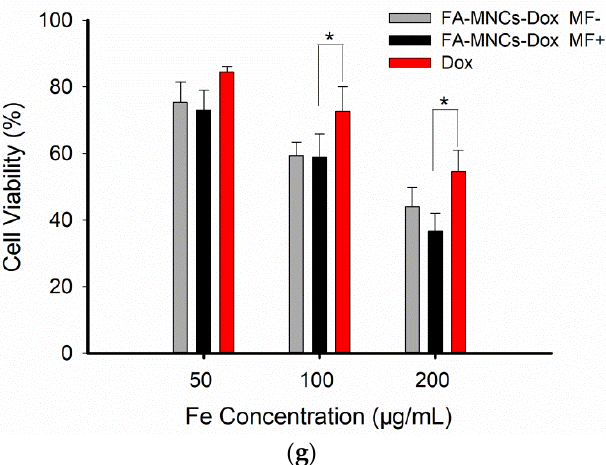
Figure 4. Killing of leukemic cells in vitro by the magnetic nanochains actuated by rotational magnetic field. ( a ) Rotational magnetic field significantly reduced the survival rate of K562 cells. ( b ) Morphological alteration of K562 cells treated by rotational magnetic field. (MF − means there is no magnetic field, while MF+ means there is a magnetic field. Scale bar: 50 µ m). ( c ) TEM image of intracellular distribution of magnetic nanochains. Inset is the local magnification. ( d , e ) TEM images of lysosomes containing magnetic nanochains in the absence (MF − ) and the presence (MF+) of the magnetic field, respectively. Under the treatment of the magnetic field, the nanocarriers can be seen in the cytoplasm, meaning the lysosomes were partially destroyed. ( f ) Apoptosis of K562 cells shown by Calcein-AM/PI staining. The number on the right was the ratio of dead cells. (FA-MNCs represent magnetic nanochains modified with folic acid. FA-MNCs-Dox represent doxorubicin-loaded folic acid modified magnetic nanochains. Scale bar: 100 μm). ( g ) Cell viability of Dox, FA-MNCs-Dox MF − and FA-MNCs-Dox MF+ for K562 cells were calculated based on OD values of CCK-8, and Dox content in the Dox group was the same as that in FA-MNCs-DOX (MF- means there is no magnetic field, while MF+ means there is a magnetic field). Data are presented as mean ± SD, *, p < 0.05, ***, p < 0.001.